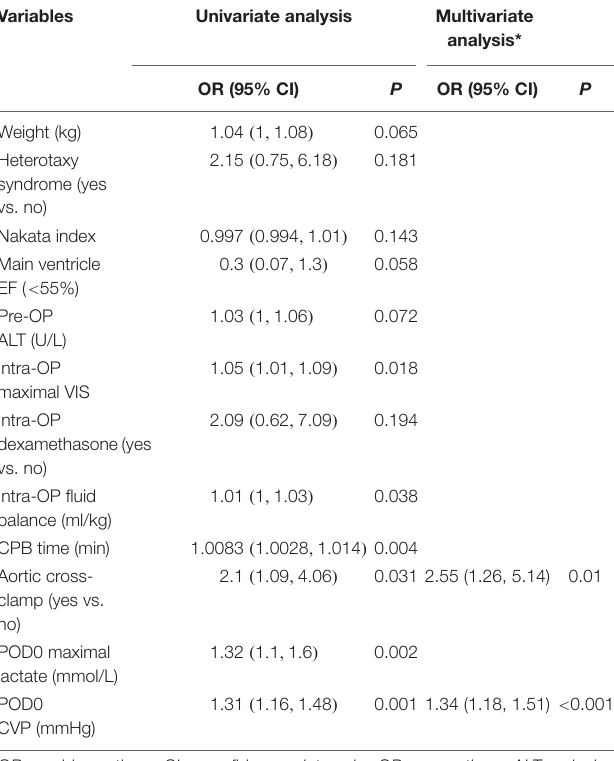
TABLE 2 | Univariate and multivariate logistic analysis for persistent liver dysfunction.